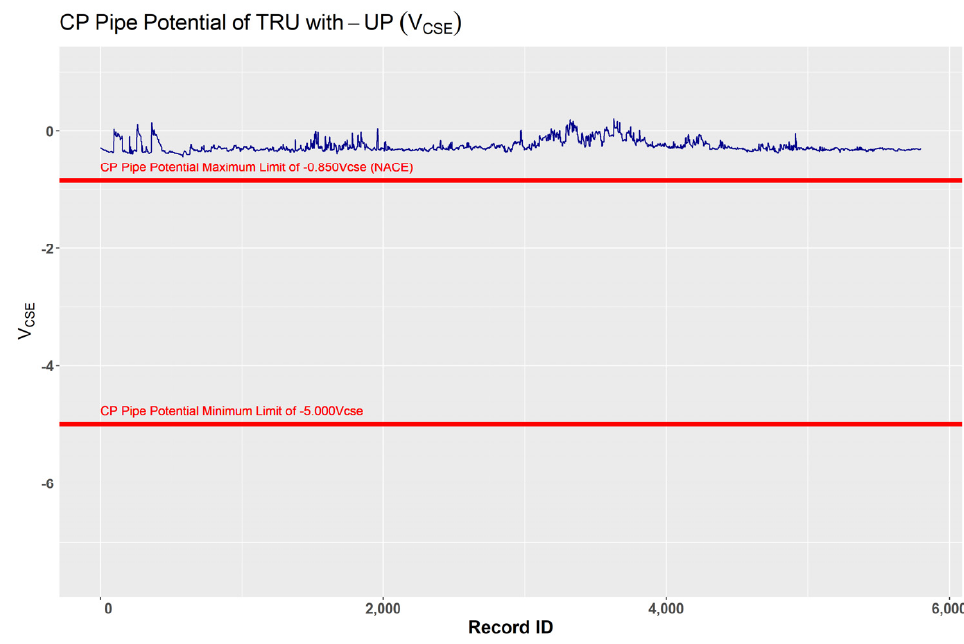
Figure 7. CP pipe potential above operating window.